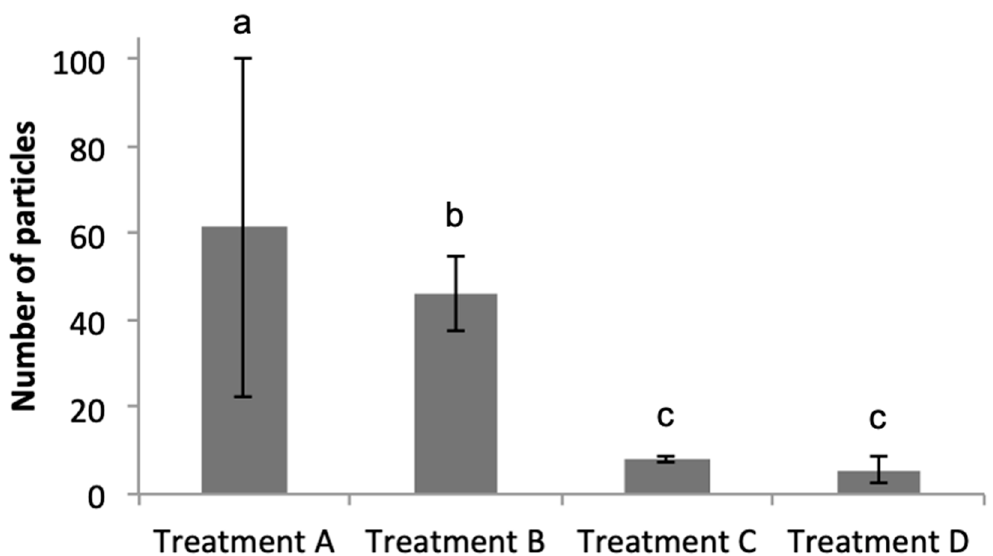
Figure 4. Total number of particles (mean values and standard deviation for three replicates) in gate “Cy3 + DAPI + ” of Figure 2 comparing all treatments A–D. Lower case letters show the results of Tukey’s post hoc test: a treatment sharing the same letter with another treatment denotes the treatments were not significantly different from each another. See Figure 3 caption for key to treatments A–D.